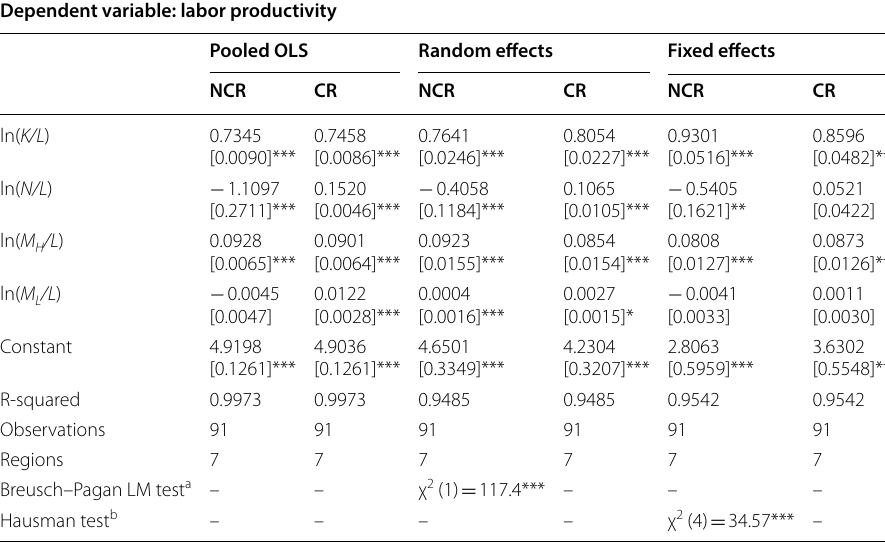
Table 4 Immigration and labor productivity in Thailand, 2003–2015